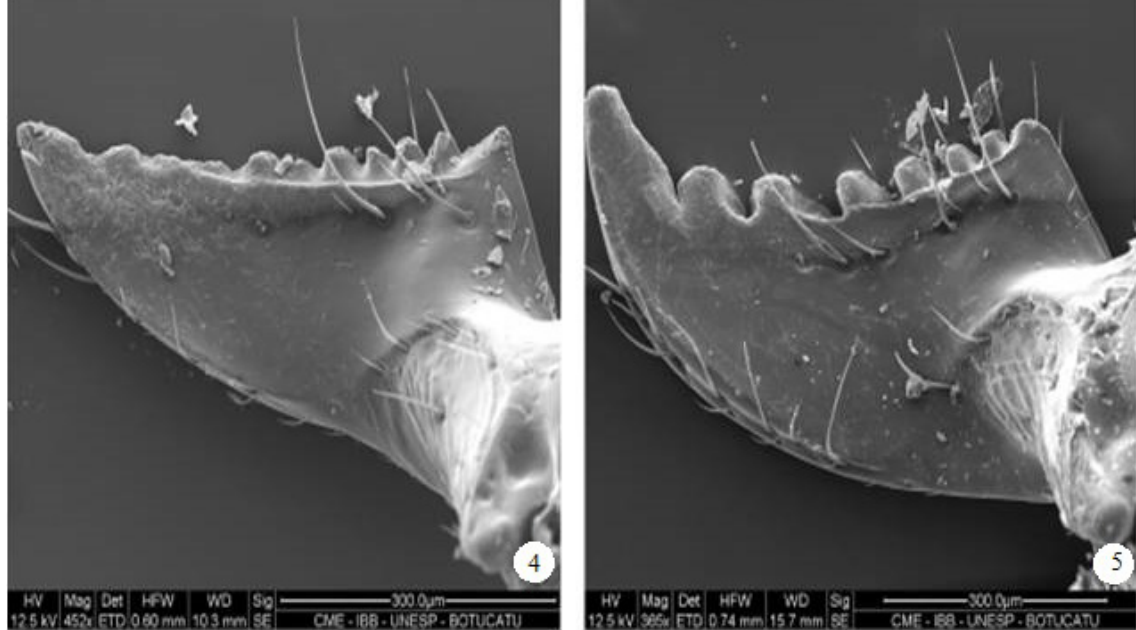
Figs 4-5. Ventral side of right mandibles of Atta bisphaerica (4) and Atta sexdens rubropilosa (5) generalist